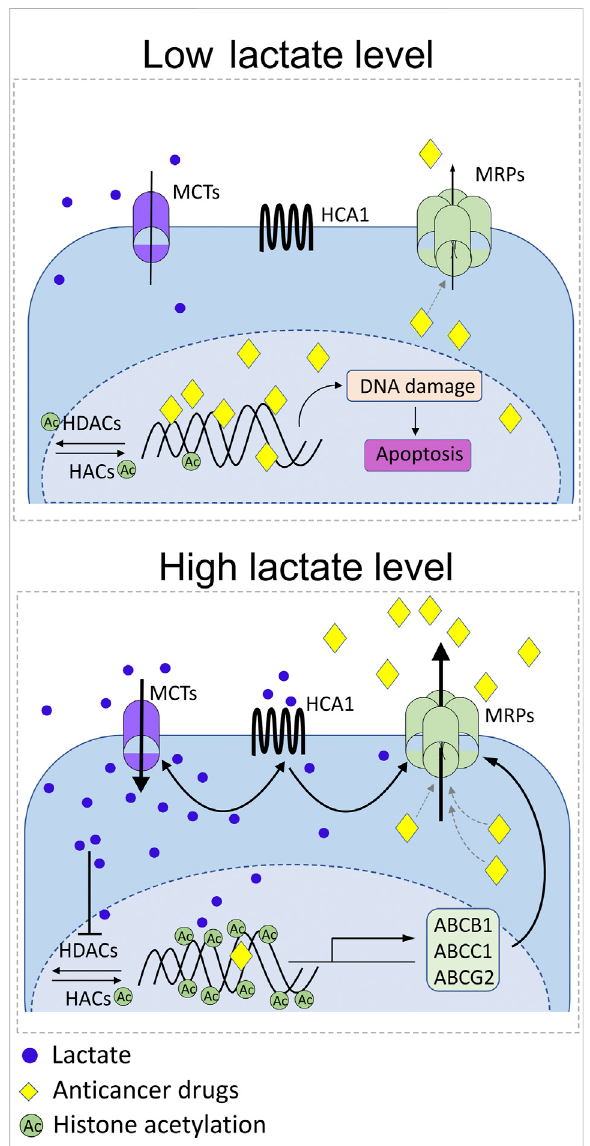
Schematic representation of the known reciprocal interplays between lactate receptor (HCA1), lactate transporters (MCTs), and multidrug-resistance proteins (MRPs). Under modest lactate levels, DNA-damaging anticancer drugs reach therapeutic concentration inside cancer cell, exert DNA damage, and trigger apoptosis (low lactate level). Rich lactate conditions in the tumor niche as a consequence of excessive glycolysis of cancer cells or symbiotic microbiota activity drive MCT-dependent lactate fl ux and develop epigenetic changes that positively drive MRP expression. Parallelly, lactate stimulates surface HCA1 that positively regulates expression of MCT1/4 and MRPs. Positive feedback loop of lactate-HCA1-MCT-lactate and lactate-HCA1- MRPs axis boosts activity of ABCB1, ABCC1, and ABCG2 in cancer cells along with decrease of anticancer drug